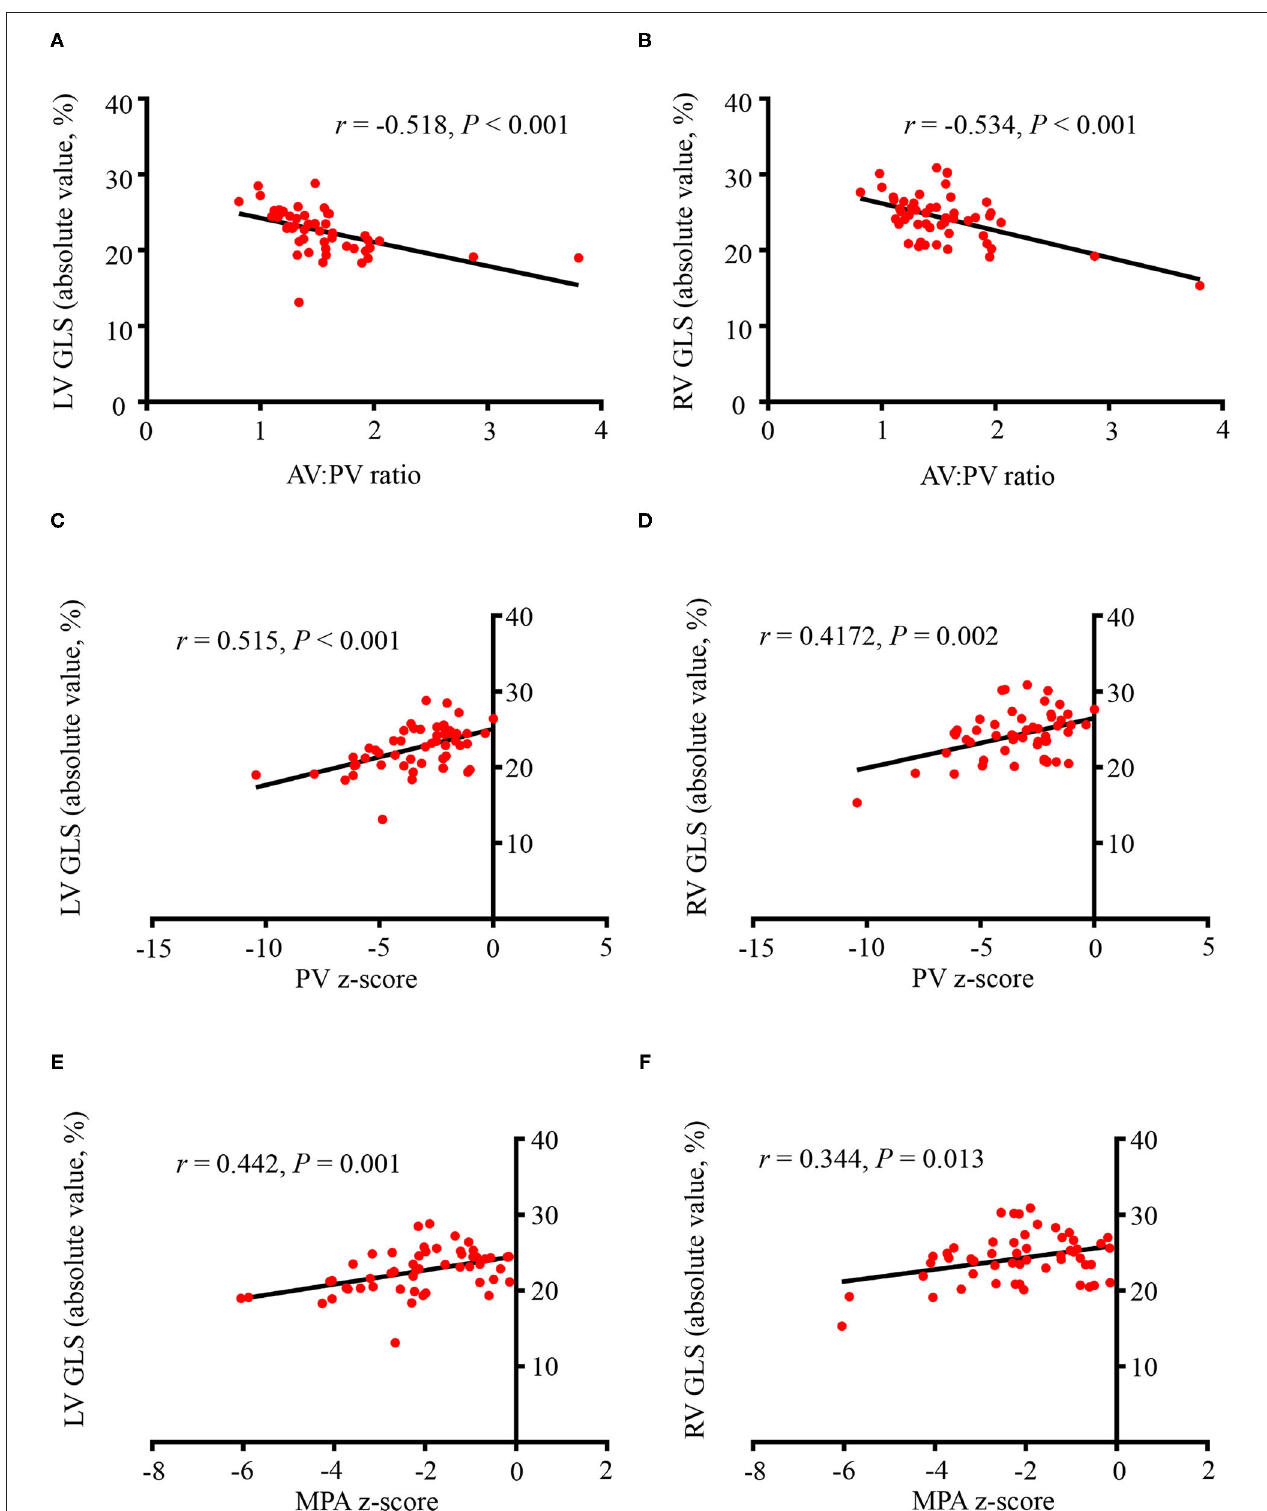
FIGURE 4 | The correlations between conventional parameters and left/right ventricular global longitudinal strains (LV GLS, RV GLS). (A) The aortic valve (AV): pulmonary valve (PV) ratio and LV GLS had a modest correlation ( r = − 0.518, P < 0.001). (B) There was a modest correlation between the AV:PV ratio and RV